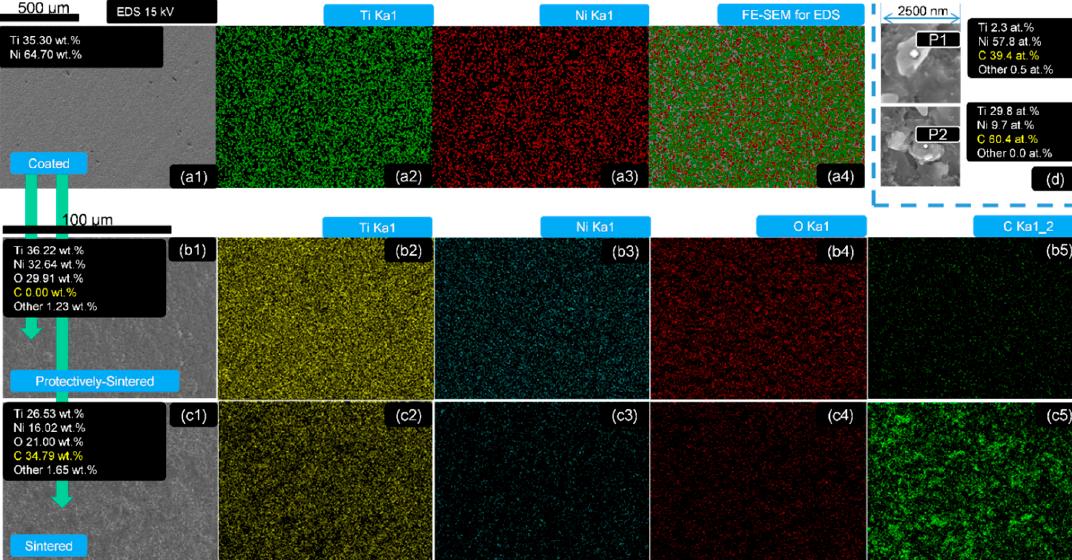
Figure 3. The EDS mapping (Ti, Ni, O, C) and detection of the samples of 500 nm depth: group ( a ) as-coated, ( a1 ) SEM photograph, ( a2 ) element Ti distribution, ( a3 ) element Ni distribution, ( a4 ) EDS mapping for all elements; group ( b ) protectively-sintered, ( b1 ) SEM photograph, ( b2 ) element Ti distribution, ( b3 ) element Ni distribution, ( b4 ) element O distribution, ( b5 ) element C distribution; group ( c ) sintered, ( c1 ) SEM photograph, ( c2 ) element Ti distribution, ( c3 ) element Ni distribution, ( c4 ) element O distribution, ( c5 ) element C distribution; ( d ) chemical compositions of the typical precipitation EDS with 2 points selected from all the sintered (protective-sintering included) samples.